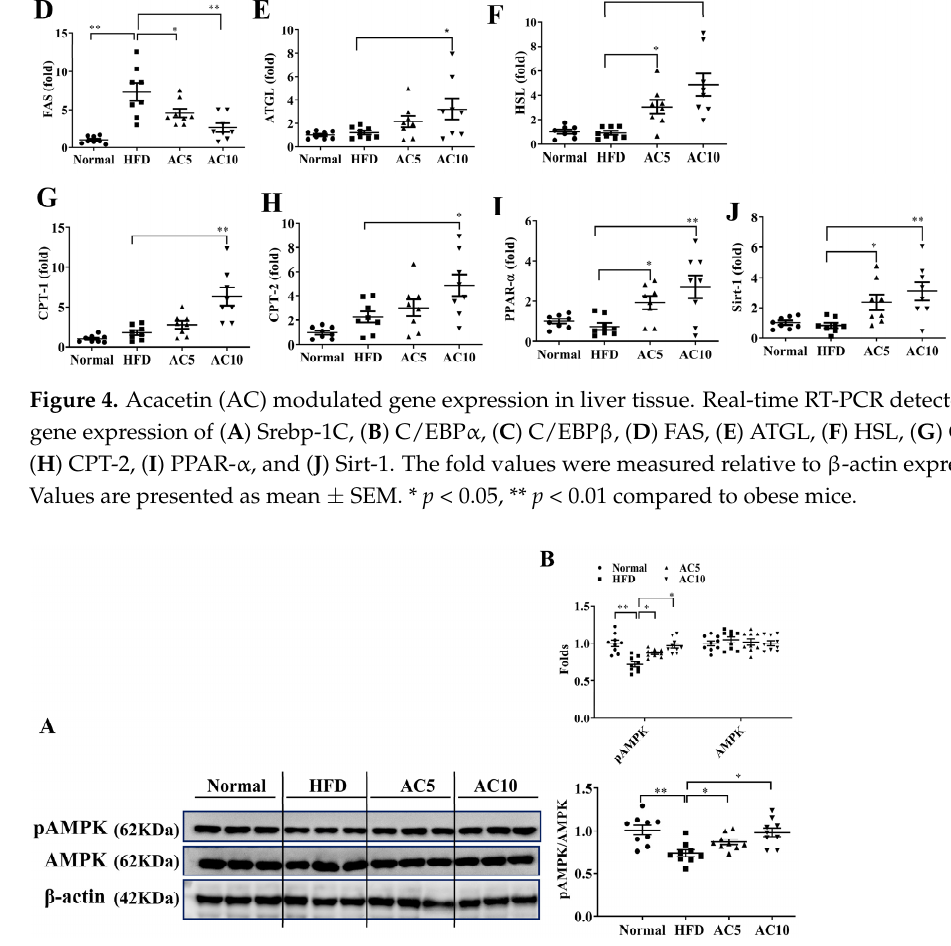
Figure 5. Acacetin (AC) regulated AMPK expression in the liver. ( A ) pAMPK and AMPK protein expressions. ( B ) The fold values were calculated relative to β -actin expression, and the ratio of pAMPK/AMPK. Values are presented as mean ± SEM of three independent experiments. * p < 0.05, ** p < 0.01 compared to obese mice.